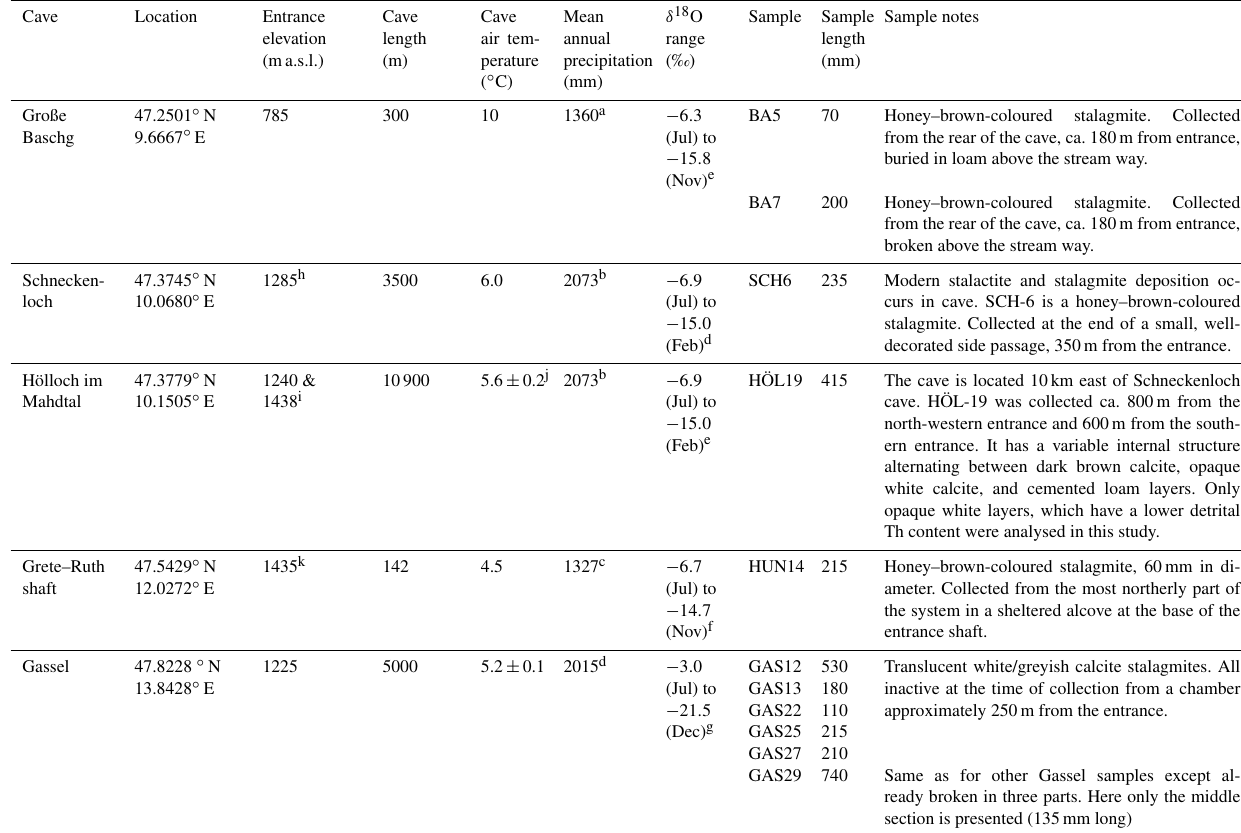
Table 1. Details of caves and speleothem samples analysed in this study, presented from west to east. See Boch et al. (2011) for details of cave and samples from the previous NALPS